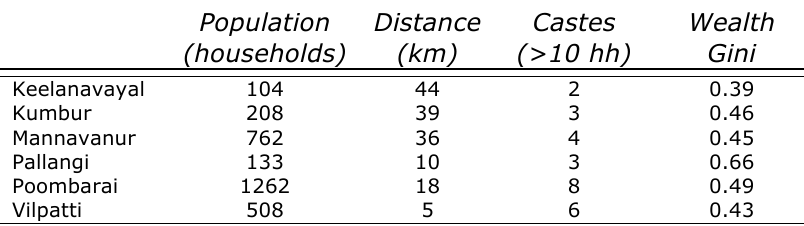
Table A 5. Village-level predictor and control